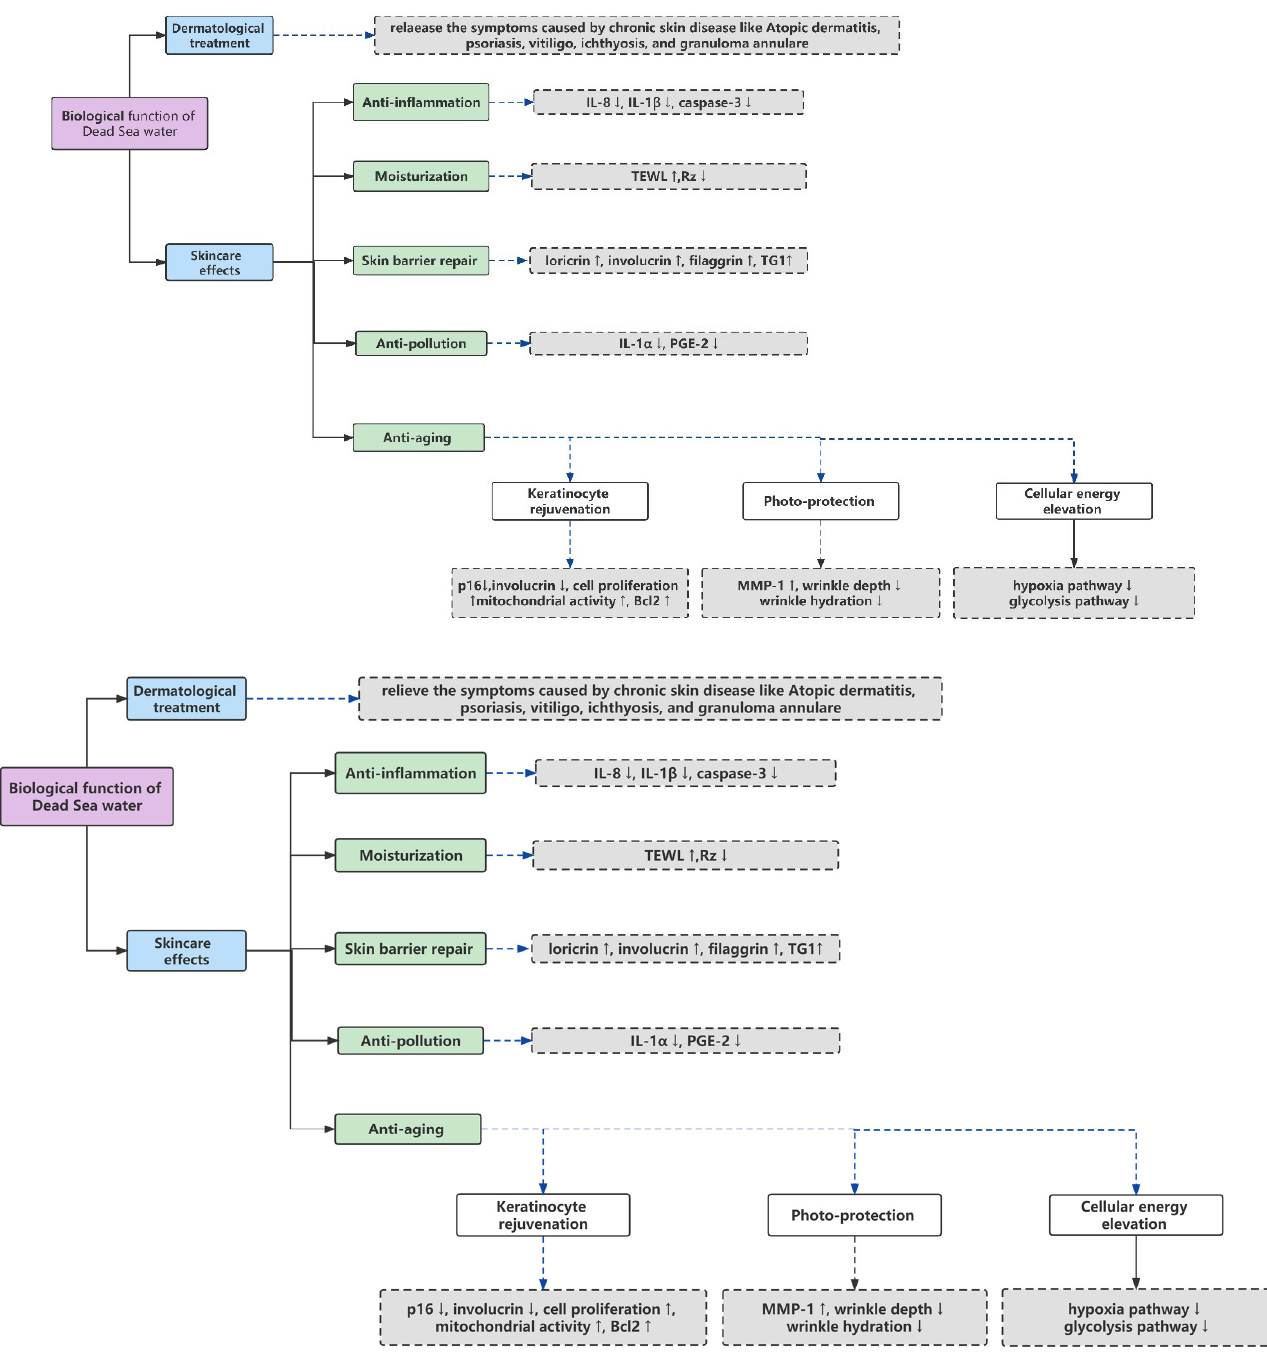
Figure 1. Overview of the biological function of Dead Sea water in dermatology and skin care.